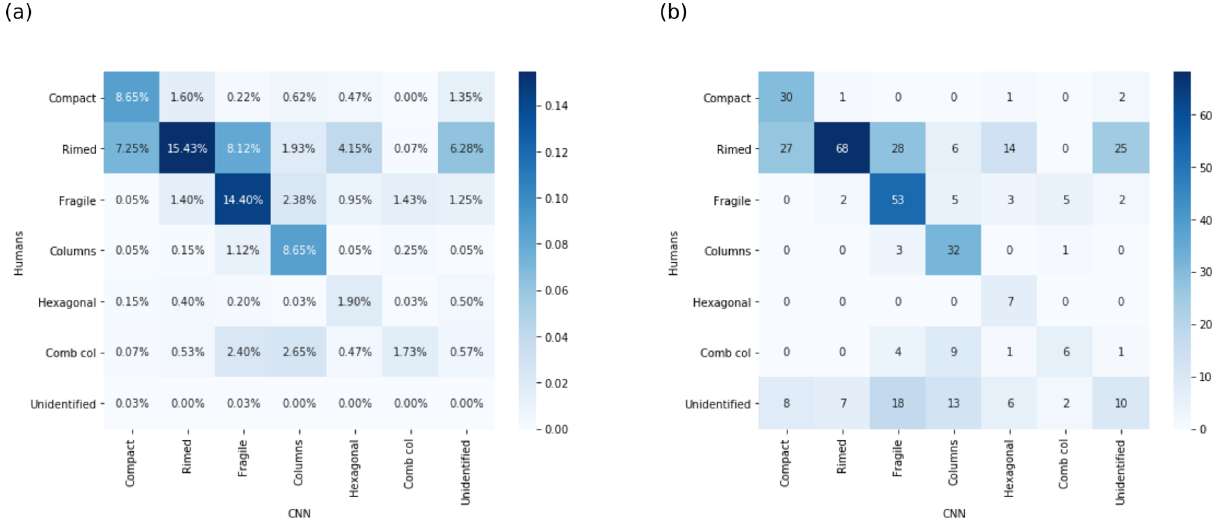
Figure 5. Comparison between human and CNN results. (a) Confusion matrix (PIP); identification threshold at 50% for the CNN results. (b) Mean confusion matrix (PIP) in numbers; identification threshold at 50% for the CNN and human results. Overall, the agreement between them is 50 . 7%. The expected porosity between CP and RA and between FA and RA seems to appear and is investigated in Fig. A3. Every one of the 40 images considered unidentified by the algorithm shows its highest score in the CP